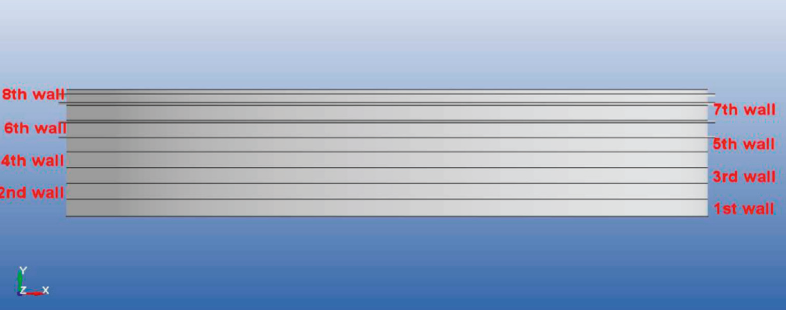
Figure 7: Distribution of eight tank